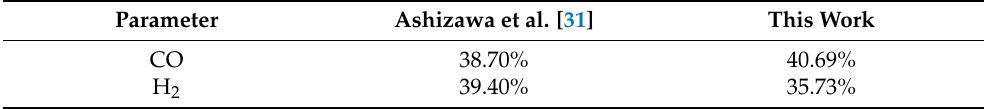
Table 5. Comparison between the results obtained in the model and the experimental